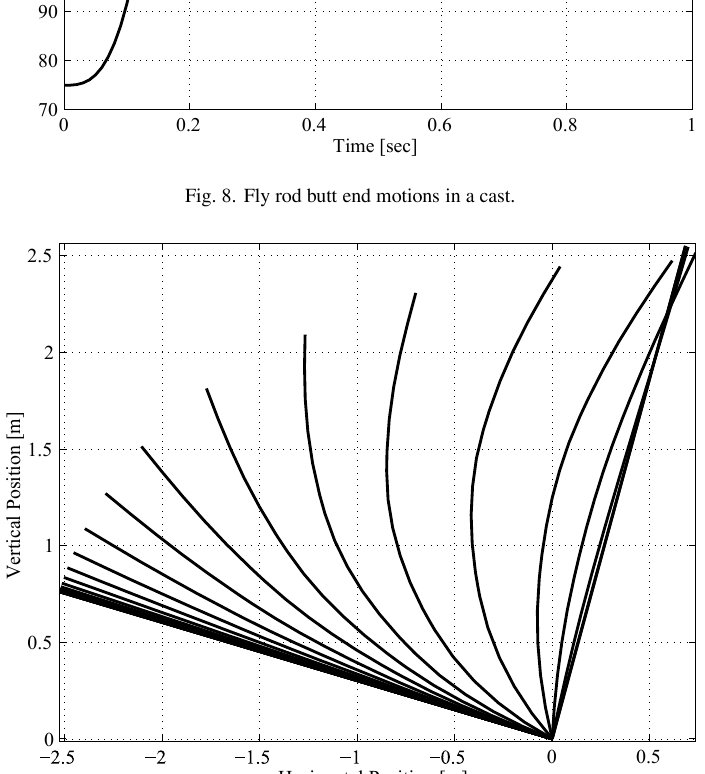
Fig. 9. Deformed shapes of a fl y rod under butt end